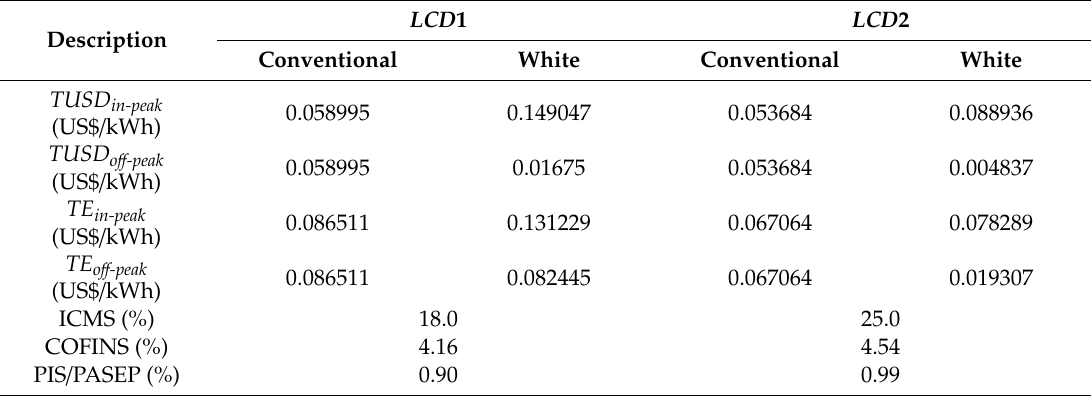
Table 1. Tari ff and rate values used in price composition calculations according to power